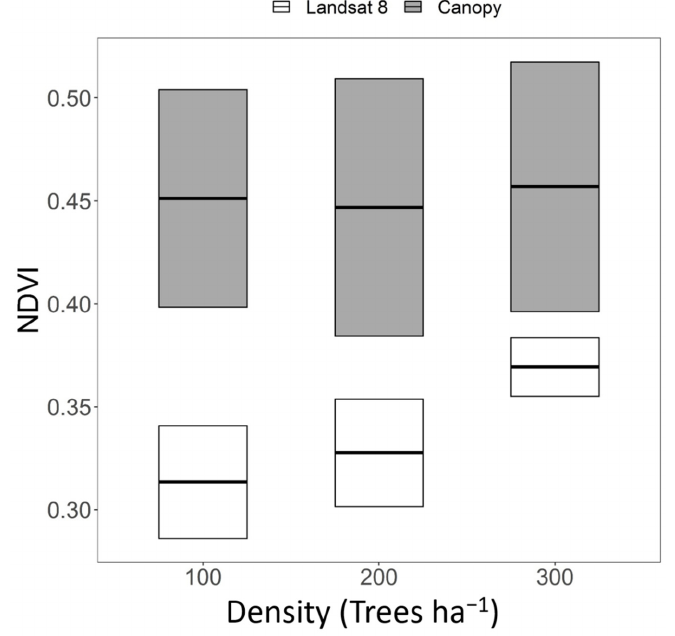
Figure 10. Retrieved Canopy NDVI (in grey) and Landsat 8 NDVI (in white) for the Yatir thinning experimental site with stand densities of 100, 200, and 300 trees ha − 1 using images that were taken on 6 August 2019. The horizontal line in each box represents the mean value, and the box boundaries indicate the range.